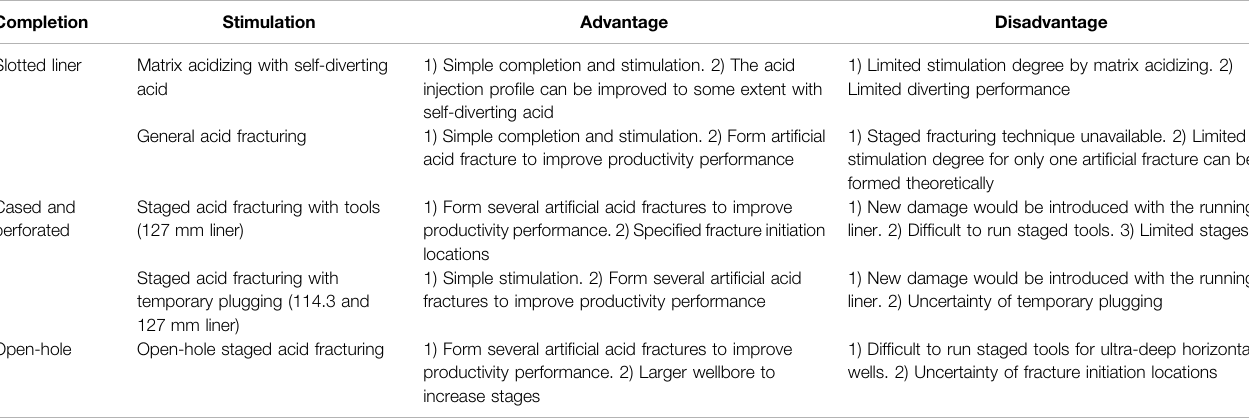
TABLE 3 | Comparison of main advantages and disadvantages of different completions and related stimulation techniques. Completion Slotted